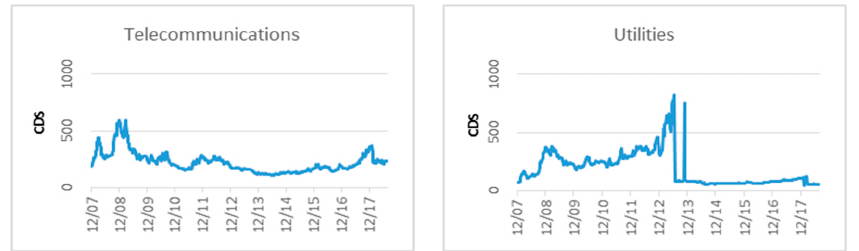
Figure 1. Time trends of U.S. sector-wise weekly CDS spreads. Each panel represents one U.S. industrial sector and the relevant weekly CDS premia for the period December 2007 to August 2018.